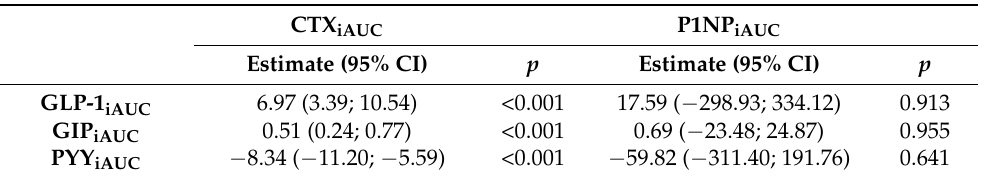
Table 3. Estimates (95% CI) of the associations between the two outcomes (CTX iAUC and P1NP iAUC ) and GLP-1 iAUC , GIP iAUC , and PYY iAUC